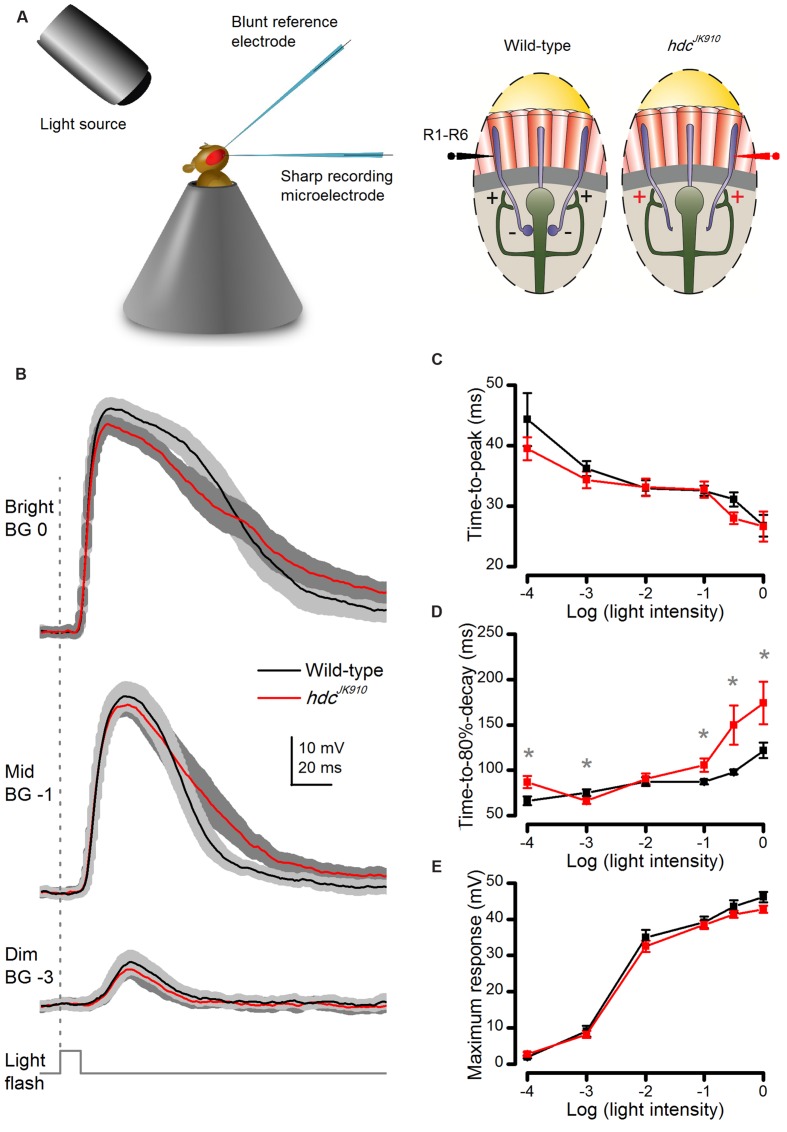
Dark-adapted hdcJK910 photoreceptors’ voltage responses to brief (10 ms) light pulses rise wild-type-like but decay slower.
(A) Schematic shows how in vivo microelectrode recordings were performed from R1–R6 photoreceptors. (B) Photoreceptors’ voltage responses to Bright, Mid, and Dim 10 ms light pulses. Mutant photoreceptors (red) took longer time than the wild-type (black) to repolarize. (C) Response time-to-peak of hdcJK910 and wild-type photoreceptors was typically similar (0.057 < p < 0.961, two-tailed t-test). (D) Average response of hdcJK910 photoreceptors typically lasted longer than that of the wild-type in experiments using brighter flashes. (pLog-4 = 0.017; pLog-3 = 0.030; pLog-2 = 0.350; pLog-1 = 0.020; pLog-0.5 = 0.025; pLog0 = 0.033, one-tailed t-test). (E) Average response amplitudes of hdcJK910 photoreceptors were wild-type-like (0.071 < p < 0.727, two-tailed t-test). (B–E): Mean ± SEM; nwild-type = 9, nhdc = 8. All recordings performed at t = 19°C.